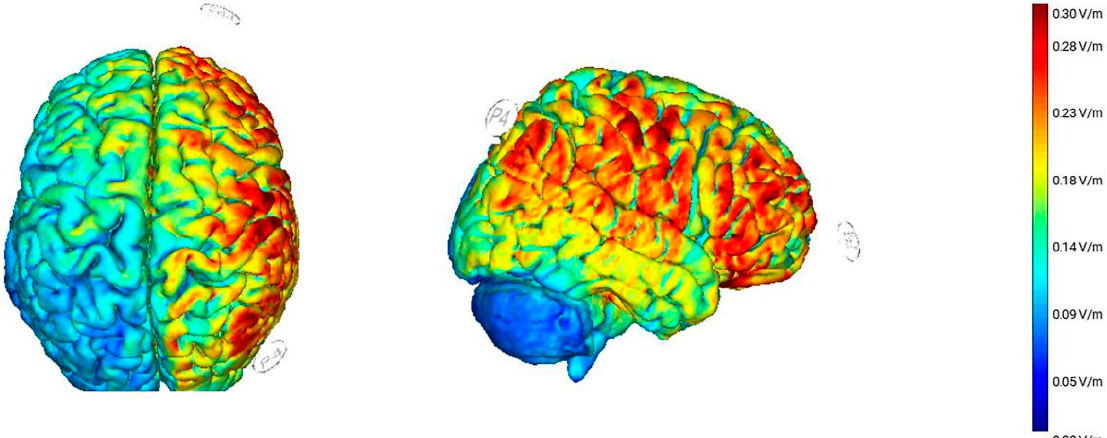
Figure 2. The tACS electrode configuration and cortical activation induced by current simulation. The tACS sponge electrodes are placed on the right parietal cortex (P4) and the right eyebrow orbit (FP2). Using the software NIC2.0, the norm of the electric field (V/m) is depicted on an example brain from a transverse and right sagittal view.